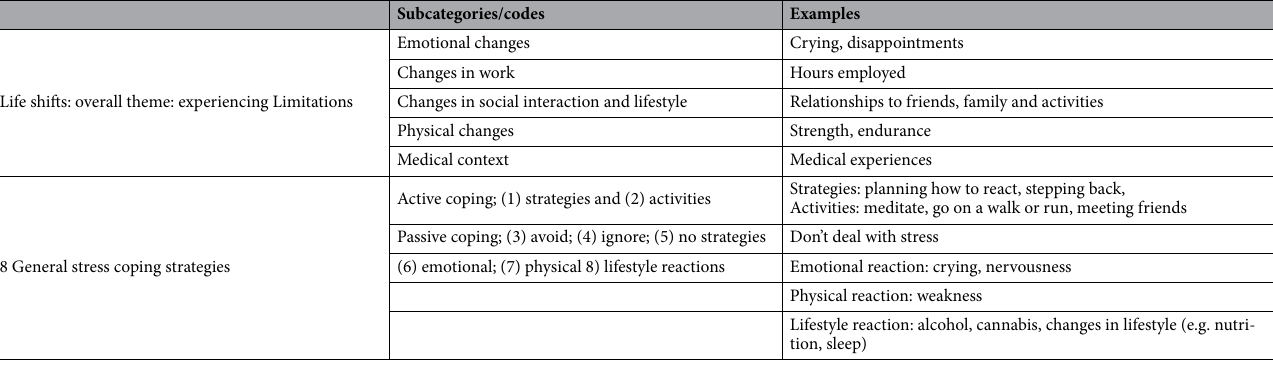
Table 2. Qualitative interview results—coding/category